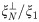
Bead model and ellipsoid model theories and measurements.(a): Schematic of the bead model and ellipsoid model theoretical frameworks representing rod-like objects. Bead model is a rigid array of identical touching beads each with diameter 2r; ellipsoid model is composed of major axis L/2 and minor axis r; Chain length in bead model in terms of number of beads N is equivalent to aspect ratio of ellipsoid L/(2r). (b): Experimental values for ξN⊥/ξ1 (red color dots) plotted along with experimental values for ξN∥/ξ1 (cyan color dots) versus chain length N. Theoretical curves are from Eqs 14 and 15 substituted with appropriate values of γ based on bead model and ellipsoid model as listed in Table 1, and HYDRO++ values in Table 2.